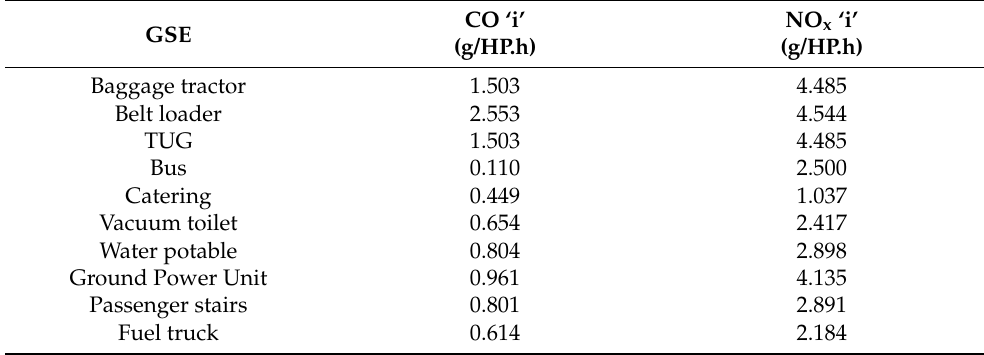
Table A4. Emission factor according to GSE type of